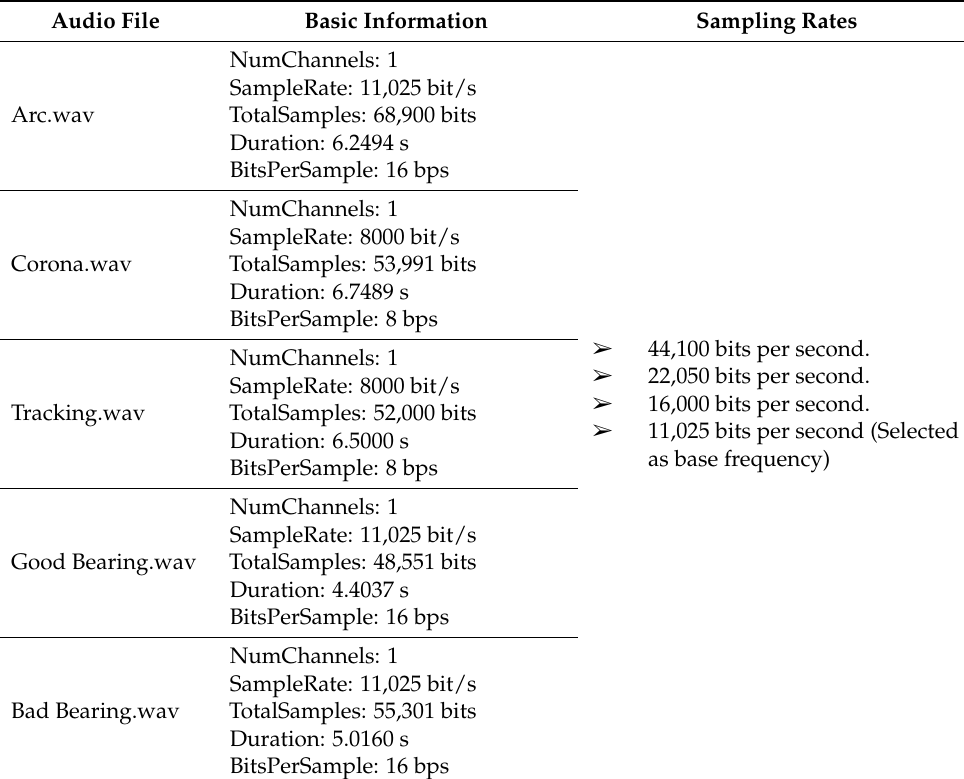
Table 1. Basic information of the sample